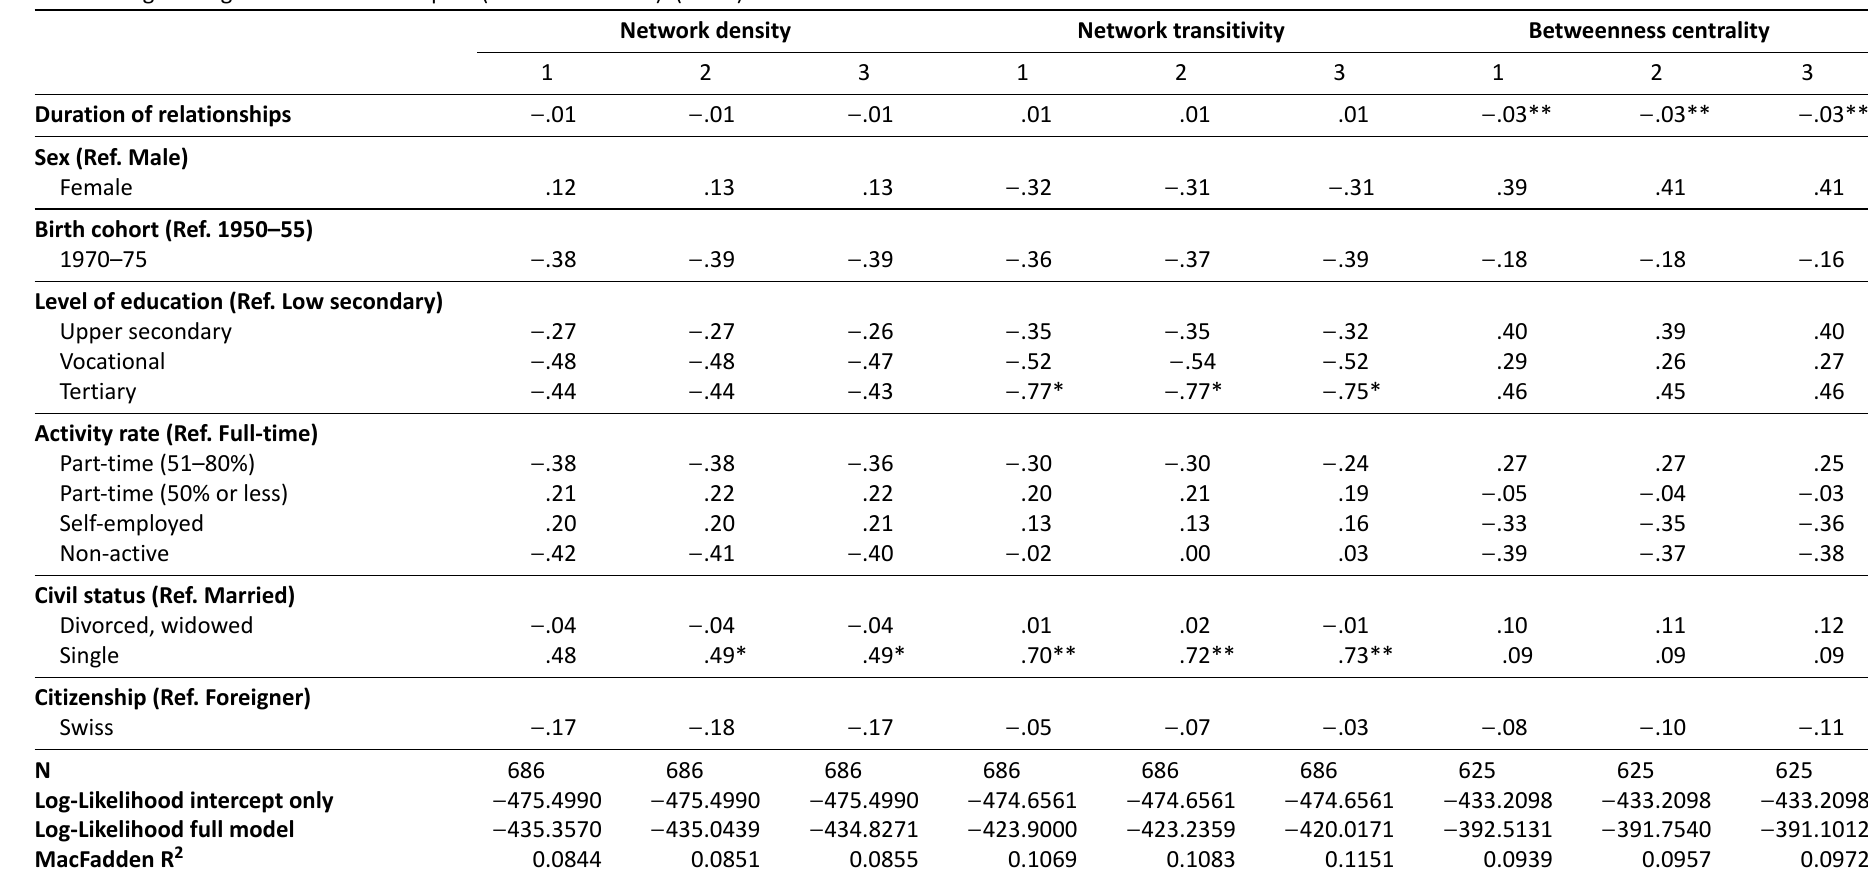
Table 3. Logistic regressions of social capital (beta coefficients).